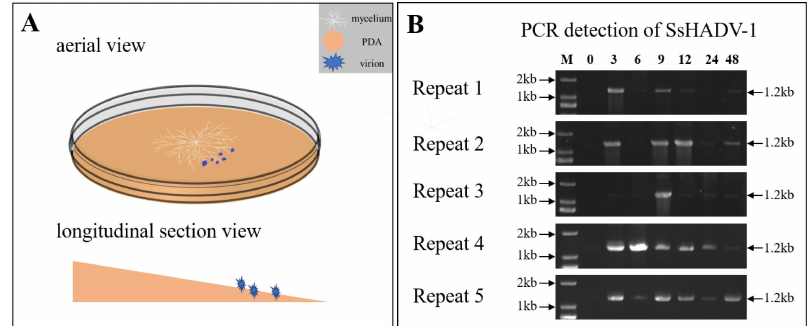
Figure 1. ( A ) Schematic diagram of SsHADV-1 virion inoculation on an angled plate. White, sandy brown, and blue colors represent the mycelium, PDA, and SsHADV-1 virions, respectively. After the mycelium grew on cellophane-covered PDA for 36 h, the virions were added to the lower mycelial tips. Subsequently, the upper mycelia were collected at different time points. Briefly, 15 µ L of SsHADV-1 virion (2 mg/mL) were added, and strain Ep-1PNA367 was cultured under 20 ◦ C conditions. ( B ) SsHADV-1 detection in healthy tissue after mycelia inoculation with virions at different time points (0, 3, 6, 9, 12, 24, and 48 h). SsHADV-1 was detected with specific primers (Table S6) for five biological replicates. The PCR production size was about 1.2